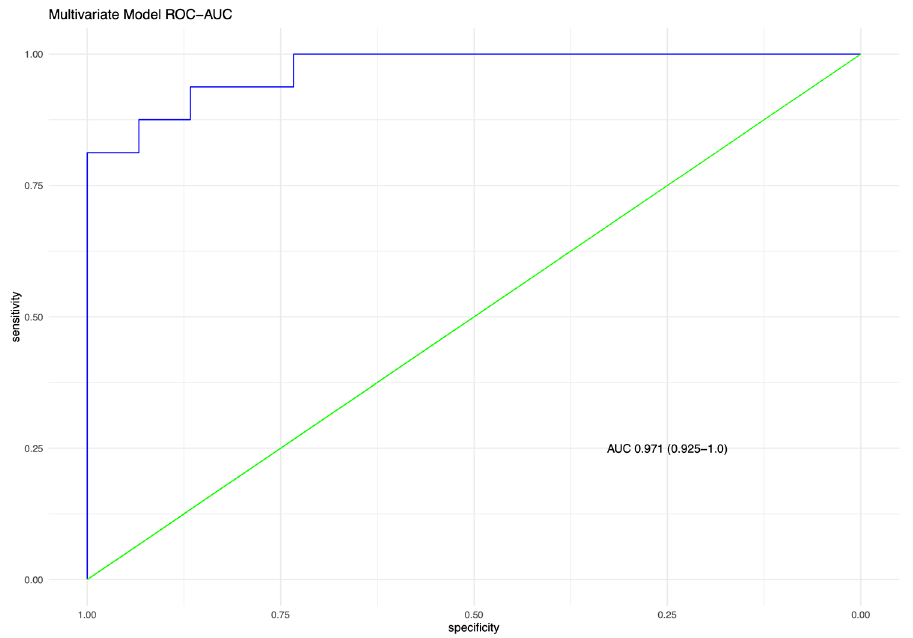
Figure 4. Receiver operating curves (ROC) for multivariate model for DIPNECH diagnosis. Combi- nation of nodule number, Airway-artery ratio and Airway wall thickness- artery ratio (AUC 0.97).